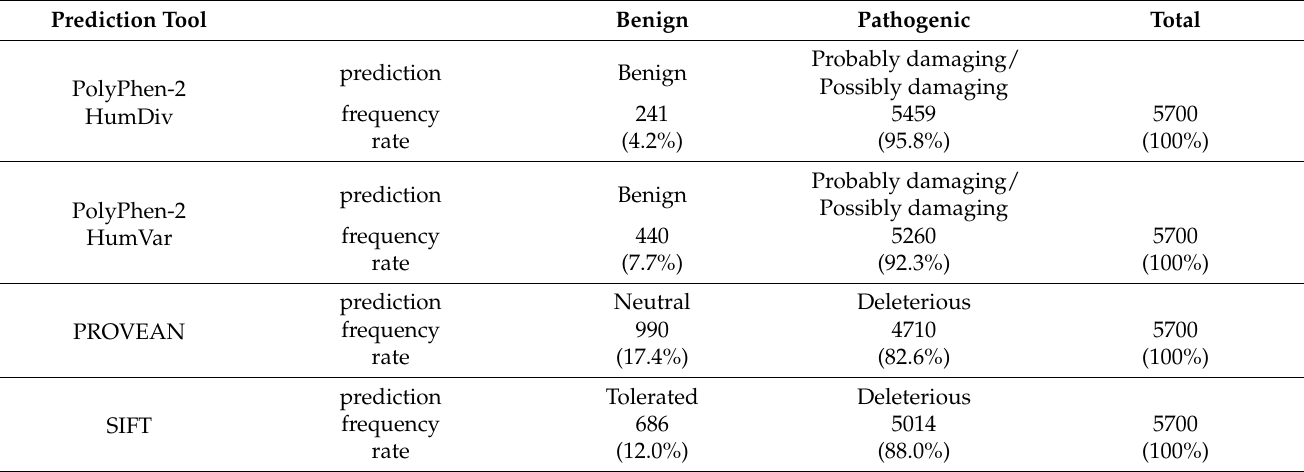
Figure 1. ( a ) Schematic illustration of human CDKL5 primary structure showing amino acids 1 to 300. The catalytic domain is colored blue. ATP-binding site, S/T kinase active site, and the TEY sequence are shown in orange. aa; amino acids ( b ) CDKL5 amino acid sequences of Mus musculus, Pan troglodytes, Macaca mulatta, Gallus, Xenopus tropicalis, and Danio rerio were aligned with CDKL5 from Homo sapiens. Orange lines indicate the ATP-binding site, S/T kinase active site, and TEY motif. Red and yellow lines indicate β -sheets and α -helices, respectively. The graph below the sequences indicates the match rate of each position. Identical amino acid positions in two-thirds of CDKL5s are shaded light gray. Table 1. Summary of Prediction tool